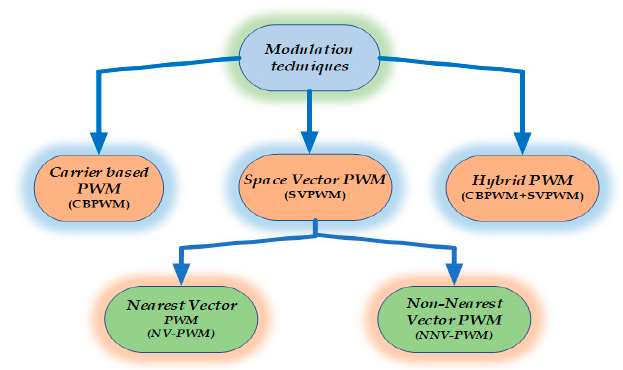
Figure 16. Classification of different modulation techniques.